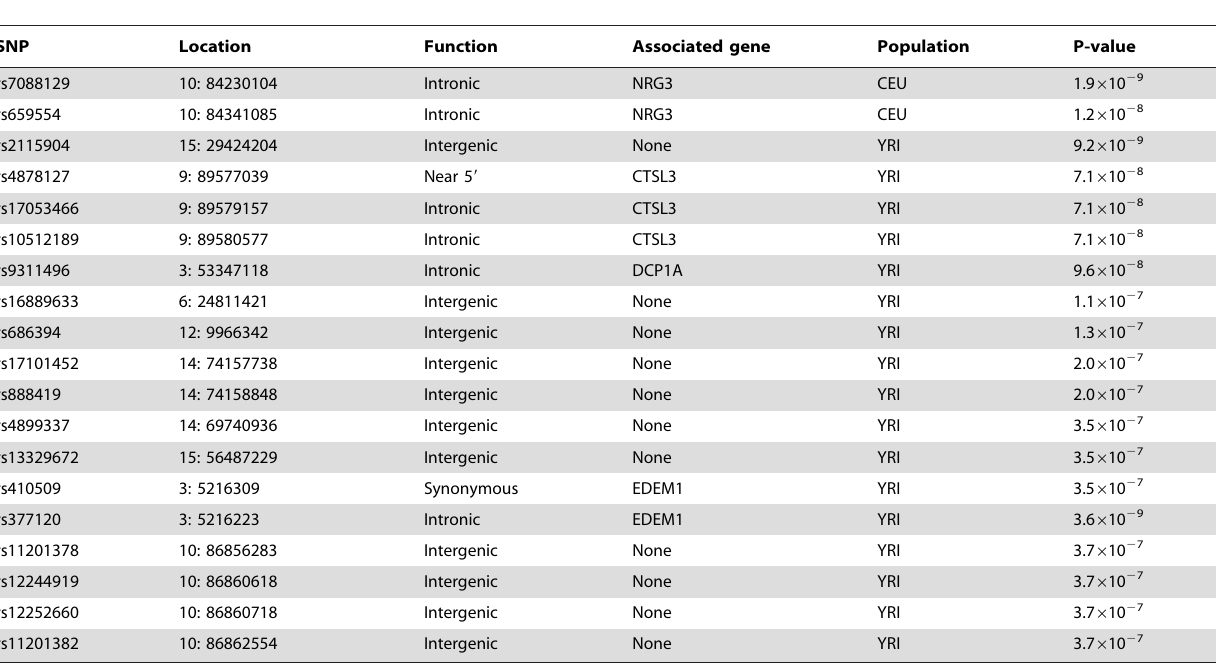
Table 1. Markers associated with the intron expression phenotype with q-values , 0.05.